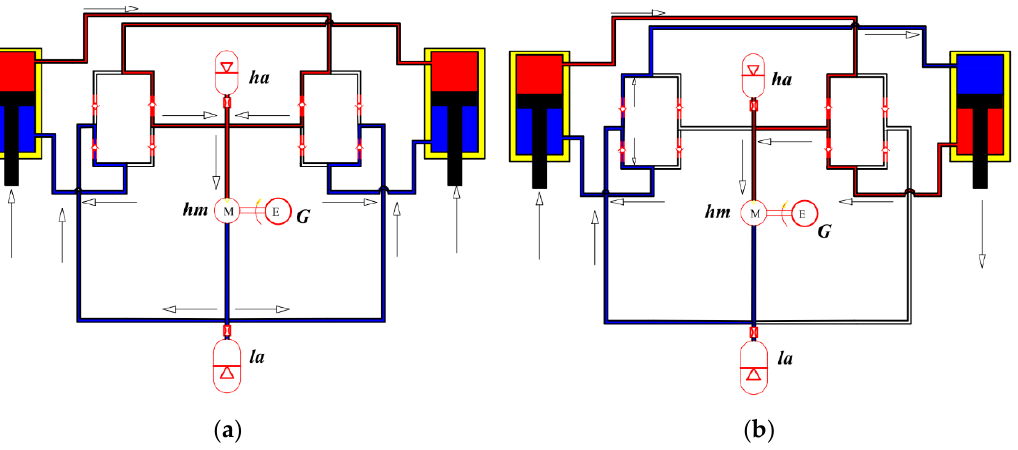
Figure 1. The structure and working process of the HIIRS in the ( a ) bounce motion and ( b ) roll motion ( la — low-pressure accumulator; ha — high-pressure accumulator; hm — hydraulic motor; G —